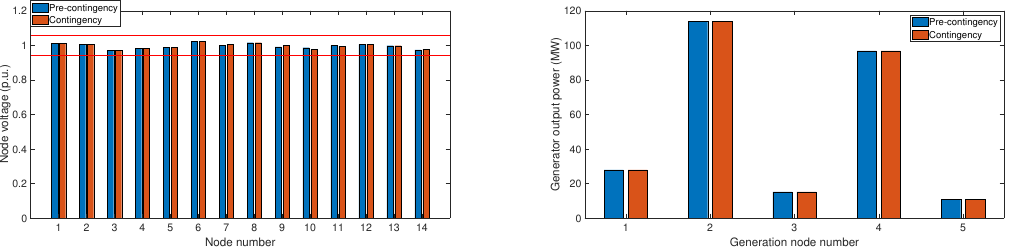
Figure 10. Voltage and power dispatched implementing the QCQP results in a power flow of the network prior to and after contingency of branch 16 (generation nodes are, respectively, nodes 1, 2, 3, 6, and